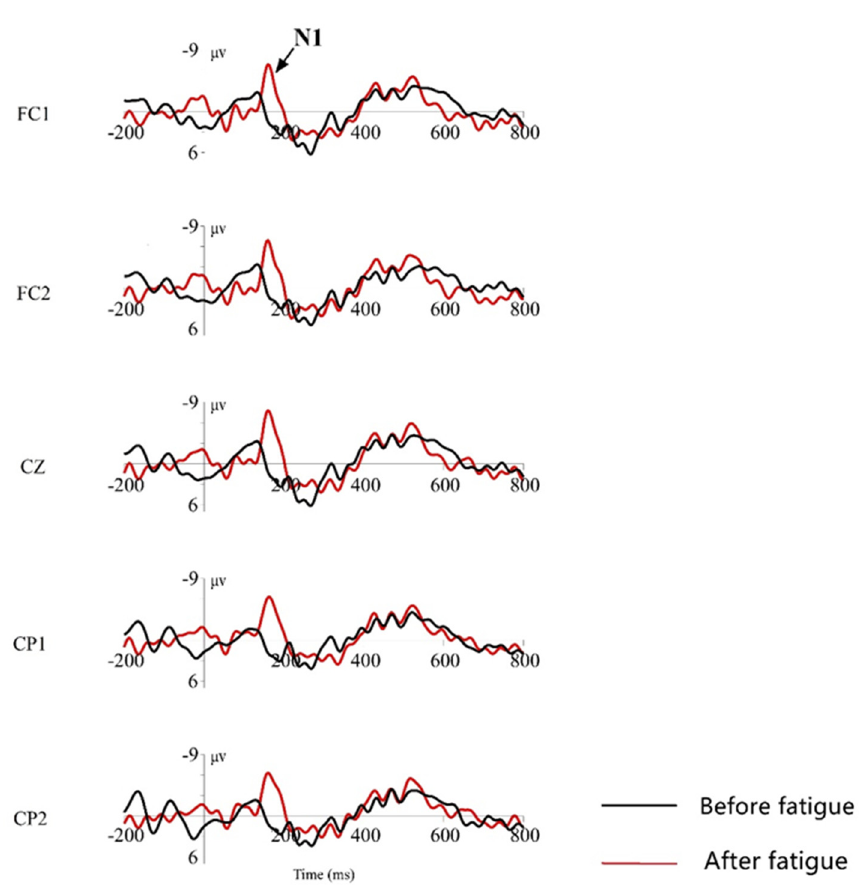
Figure 13. Total mean ERP diagrams at the FC1, FC2, CZ, CP1, and CP2 electrodes. Table 12. Paired-sample test for mean wave amplitudes of N1, N2, P2, N2, and LPC, before and after brain fatigue. Paired Differences